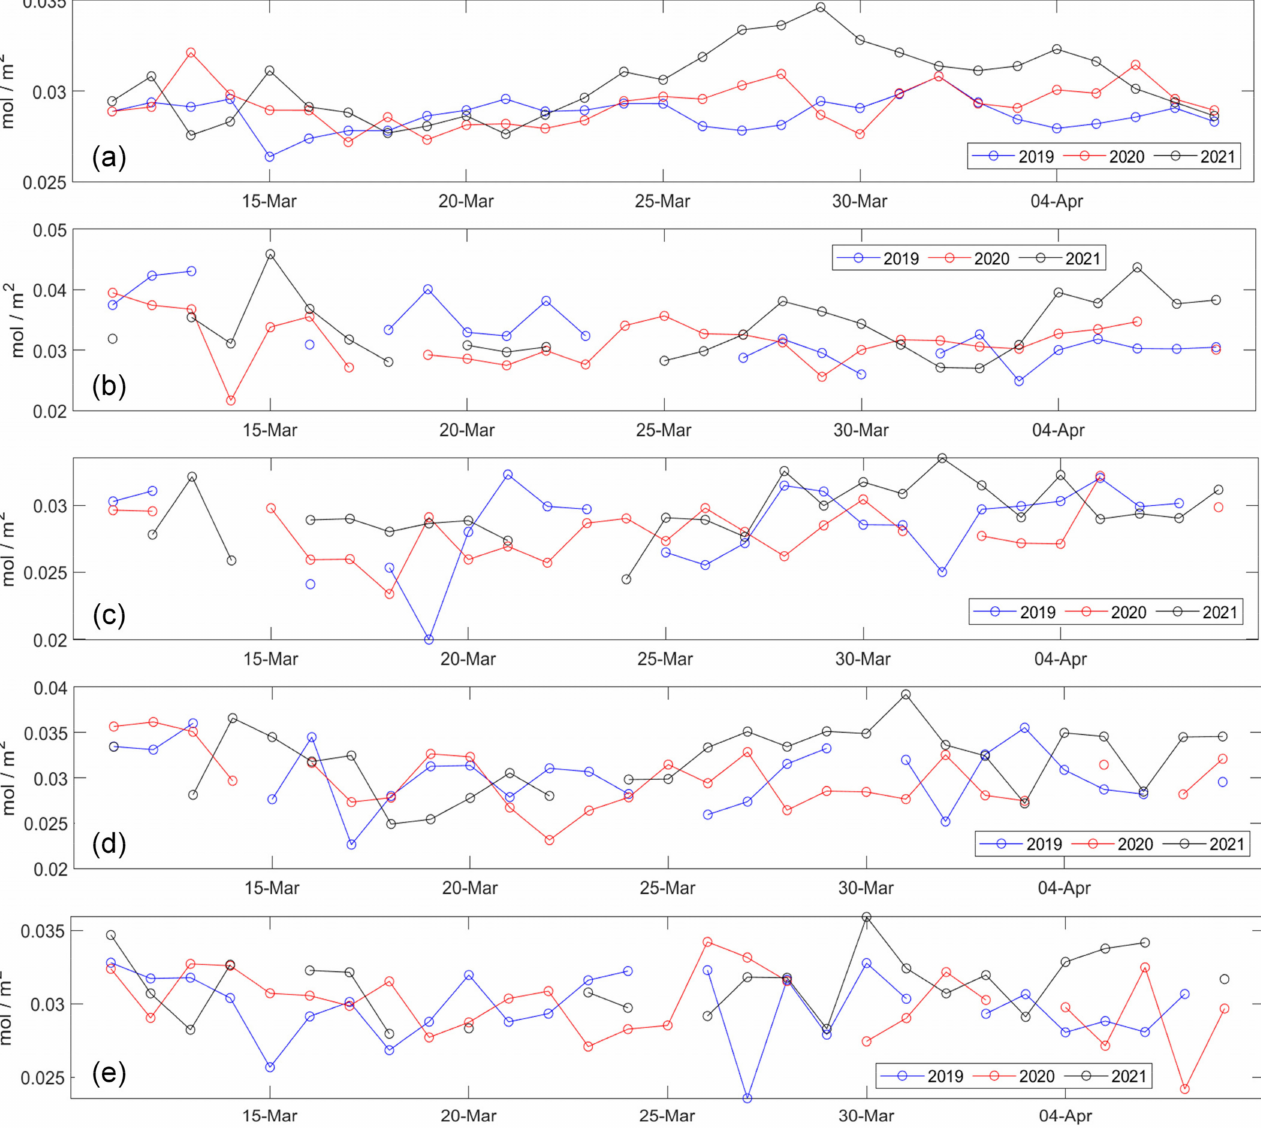
Figure 6. The trend of CO over ( a ) Iran, ( b ) Tehran, ( c ) Tabriz, ( d ) Isfahan, and ( e ) Mashhad for the 30 day period (11 March–8